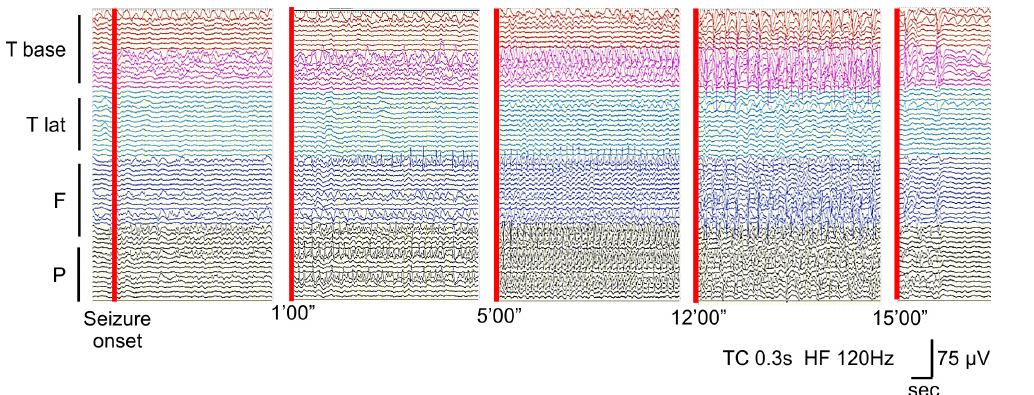
Fig 2. Seizure duration. This ECoG shows an example of a long-lasting seizure in case 2. Rhythmic seizure discharges gradually propagated from the base of temporal lobe to the frontal and parietal lobes over more than 15 min.